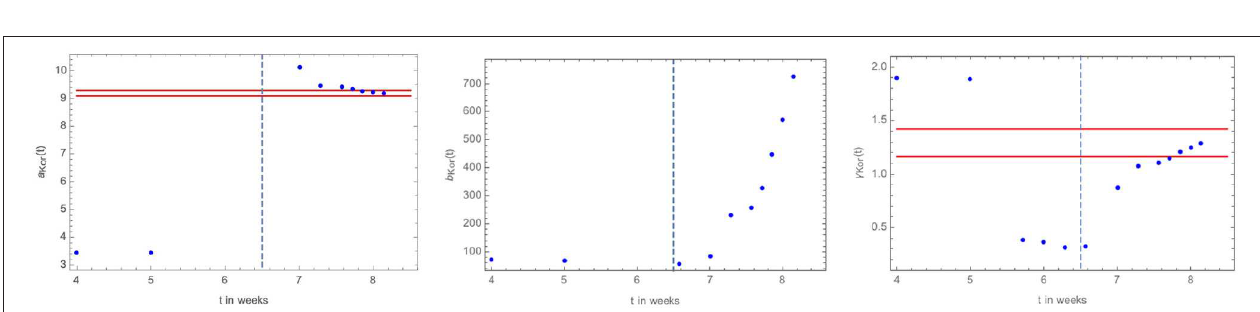
FIGURE 9 | Fit parameters to South Korea COVID-19 data as function of time. (Left) a ( t ) with the red band corresponding to a change of 0.1 in the last value of a as function of time. This translates into a 10 % change in the number of infected cases. (Center, Right) b ( t ) and γ ( t ) with the red band for γ corresponding to a 10 % change w.r.t. its last value. The vertical dashed blue line marks the occurrence of the inflection point in the infected cases according to the overall